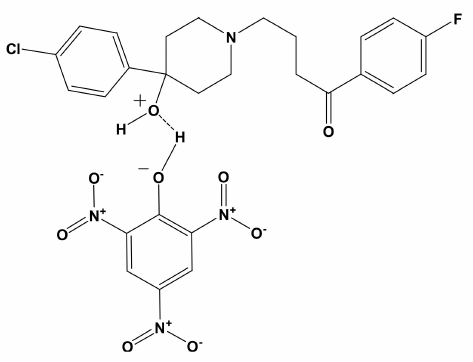
Figure 1. Charge-transfer (CT) complex of [(HPL)(PA)].